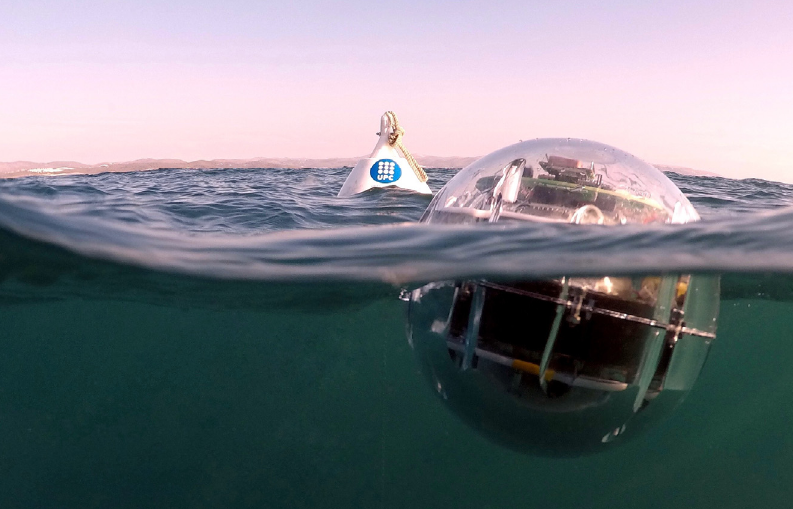
Figure 8. 20 cm, 3.6 kg spherical drifter with the embedded EH and monitoring systems during the deployment 4 km o ff shore from Vilanova i la Geltrú harbour. A white mooring buoy with the UPC deployment 4 km offshore from Vilanova i la Geltr ú harbour. A white mooring buoy with the UPC logo indicates the fi shing-protected area. logo indicates the fishing-protected